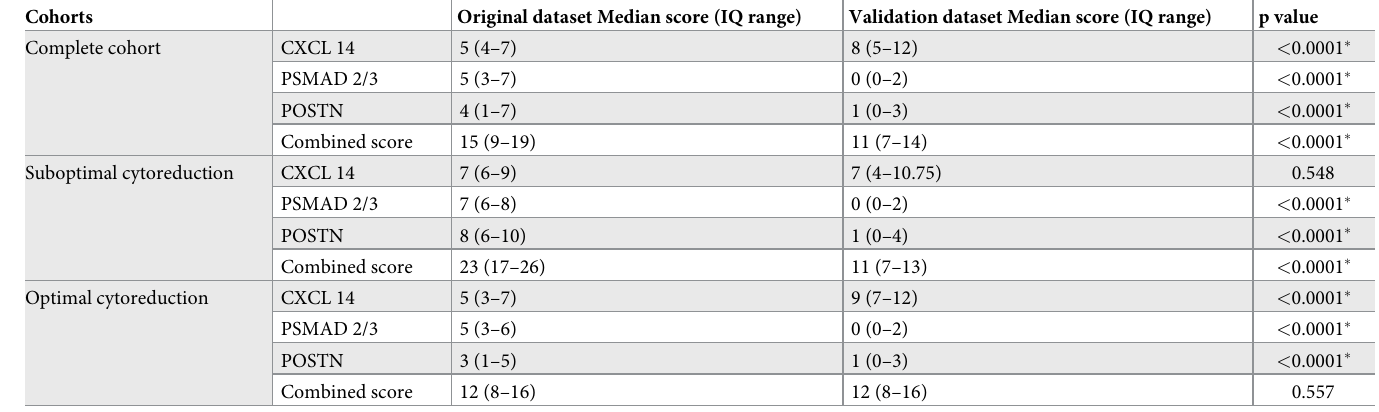
Table 3. Comparison of median scores for each protein.